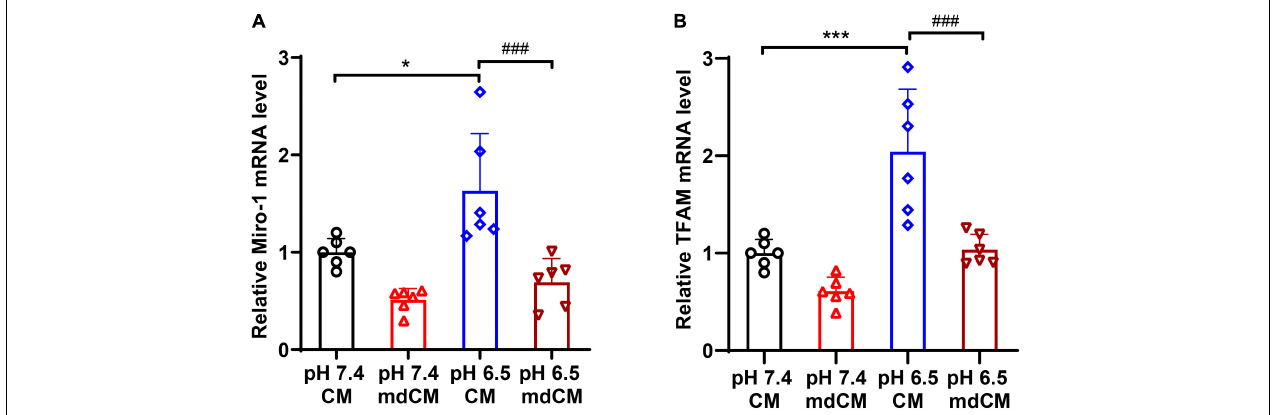
FIGURE 6 | The mRNA expressions of Miro1 and TFAM in astrocytes co-cultured with CM and mdCM from pH 7.4- and 6.5-treated neurons. The mRNA level of Miro1 (A) and TFAM (B) increased significantly in the CM from pH 6.5-treated group but no significant difference in the mdCM group. n = 6. * p < 0.05, *** p < 0.001